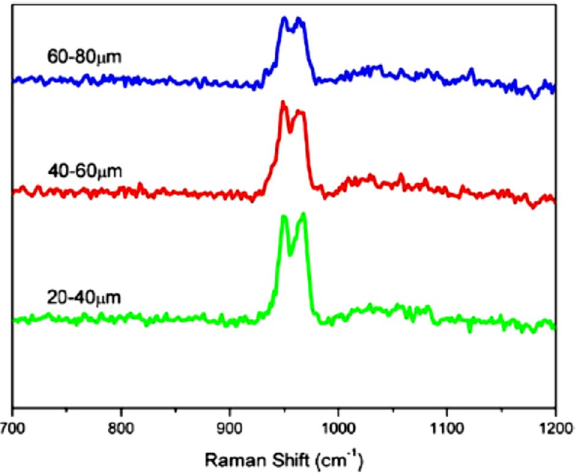
Fig. 5 X-ray diffraction patterns of hydroxyapatite HAp coatings